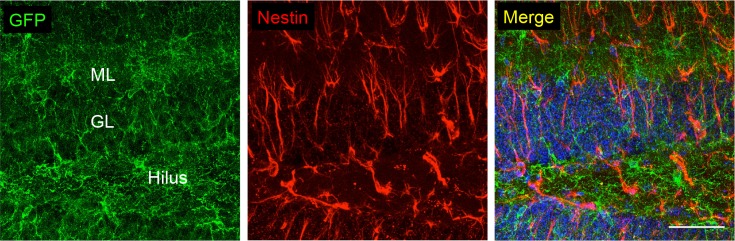
Co-stainings of EGFP (ab6556, Abcam) and the neuronal/astroglial precursor marker nestin in the subgranular zone of the dentate gyrus.Scale bars: 50 μm. DAPI staining in blue (n = 3 animals).